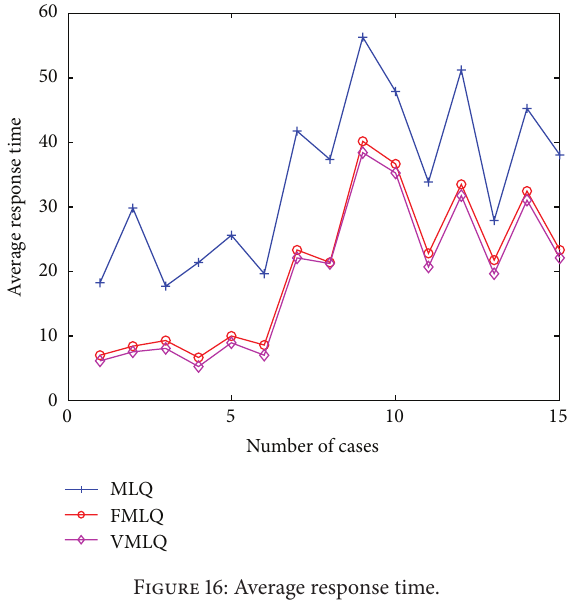
Figure 16: Average response time.